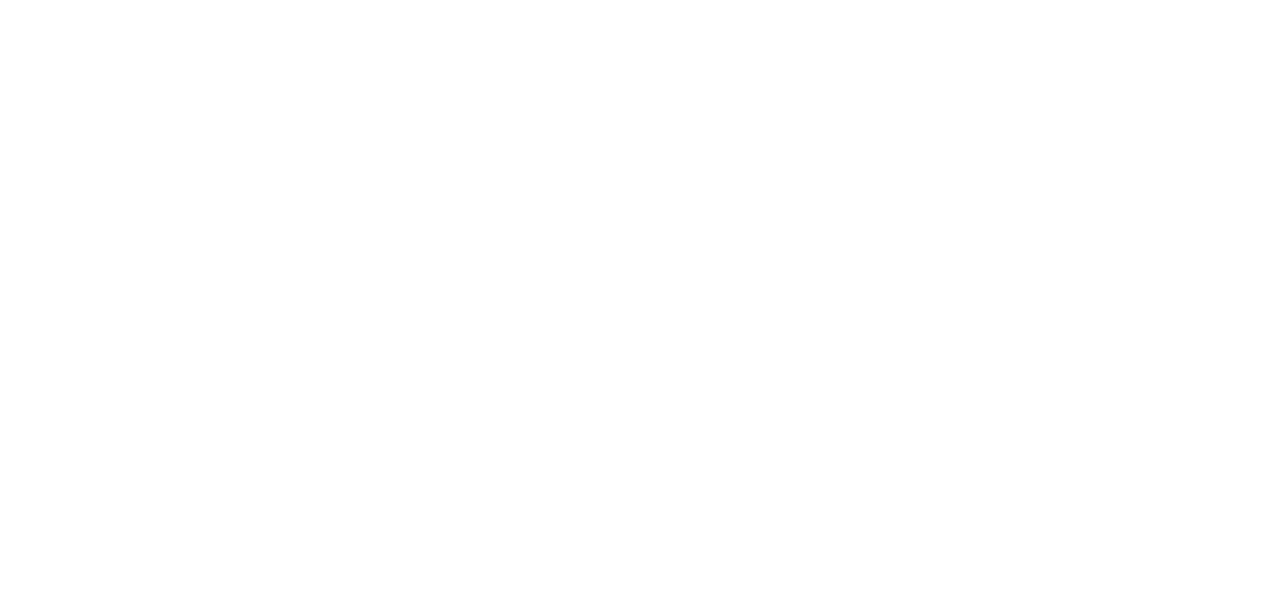
FIGUREA1 | (A) Map of rpa3 operon indicating location of ∆ rpa3 , ∆ rpap3 , and ∆ rpa3 operon deletions, as well as the Asc I and Stu I sites and the probe used to verify the deletions.The size of this fragment in the wild-type (H195) is 8kb. (B) Southern blot of genomic DNA cut with Asc I and Stu I, and probed with flanking regions of rpa3 operon ( rpa3 op. ), as shown in (A) , indicates failure to generate ∆ rpa1 ∆ rpap3 mutant as bands of the expected size for deletion are not seen (3.4 and 4.4kb). (C) Southern blot of genomic DNA cut